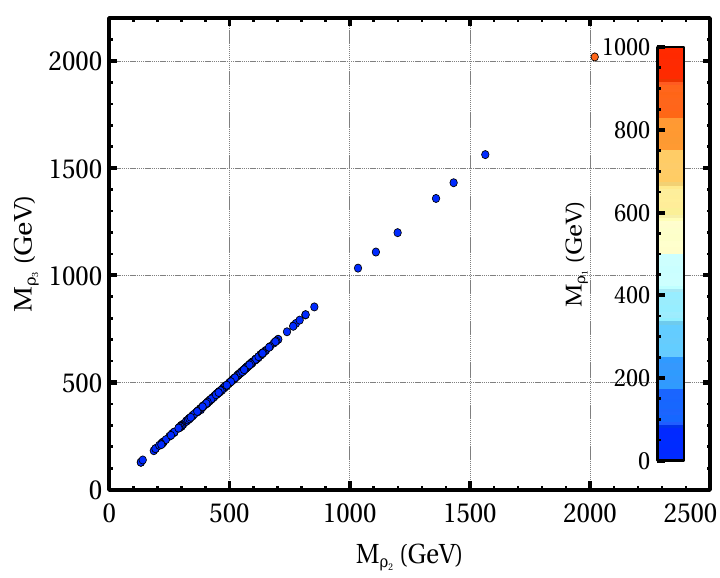
Figure 11 . Allowed values of M (cid:26) and M (cid:26) satisfying all the considered experimental constraints. 2 3 Degeneracy between M (cid:26) and M (cid:26) is indicating the fact that low values of (cid:18) D (0 : 01 < (cid:18) D (rad) < 0 : 3) 2 3 are only allowed while dark matter mass M (cid:26) lies below 100 GeV (shown in colour code). 1 neutrino trident cross section measured by the CCFR collaboration. 17 Consequently, all the crossed regions above black dashed line are excluded by neutrino trident